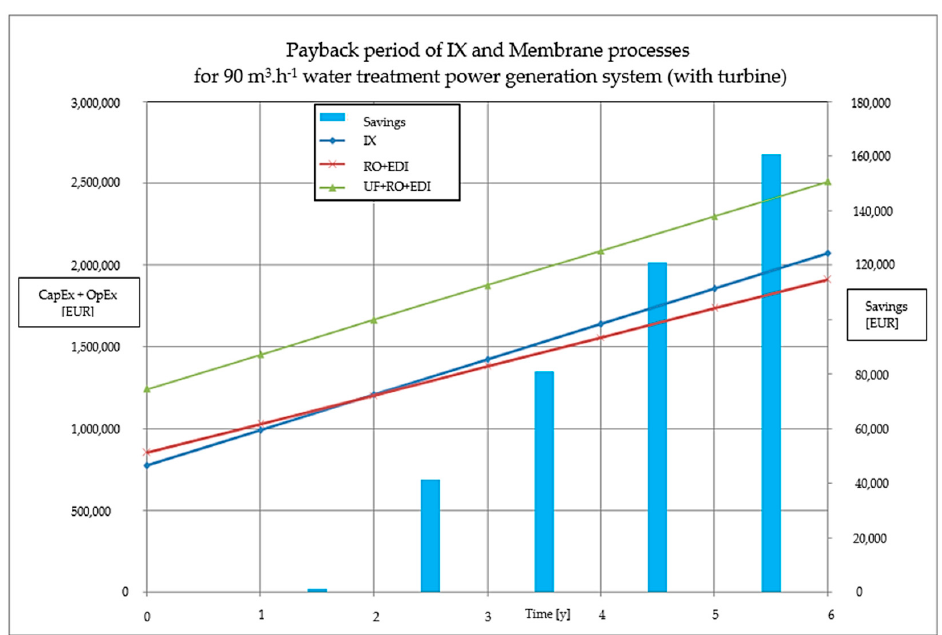
Figure 7. The payback period of water treatment in a power plant with 90 m 3 h − 1 of make-up water. Comparison of ion exchange and membrane processes.